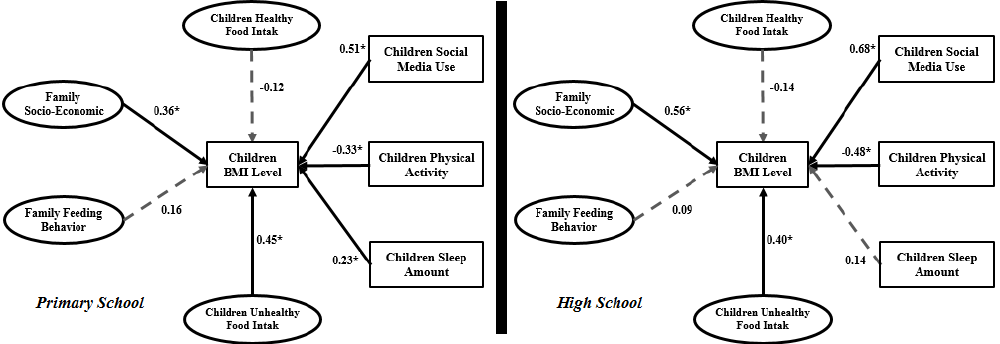
Figure 10. Structural primary and high school models. Table 6. SEM analysis outputs for primary and high school students.